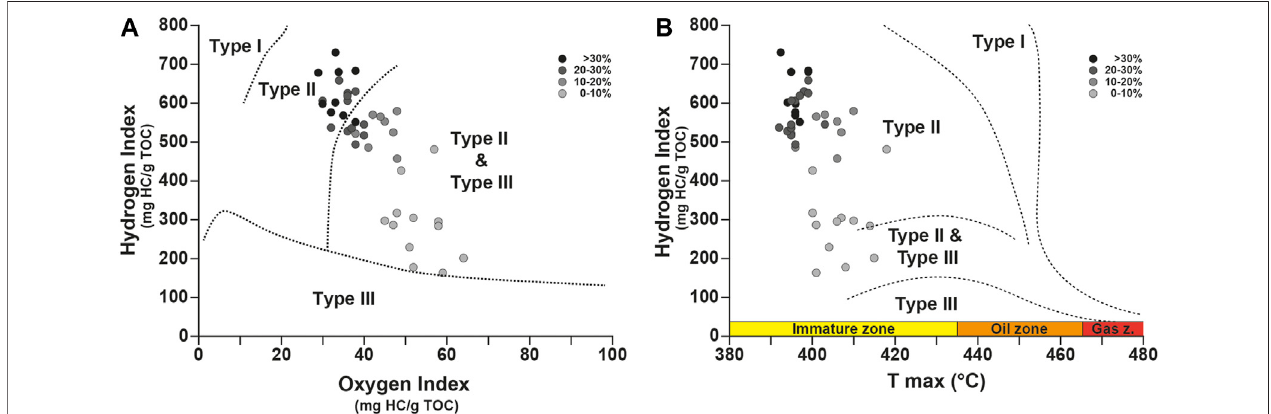
FIGURE 7 | Cross-plots of Hydrogen Index (HI) versus Oxygen Index (OI) (A) and versus T max (B) .